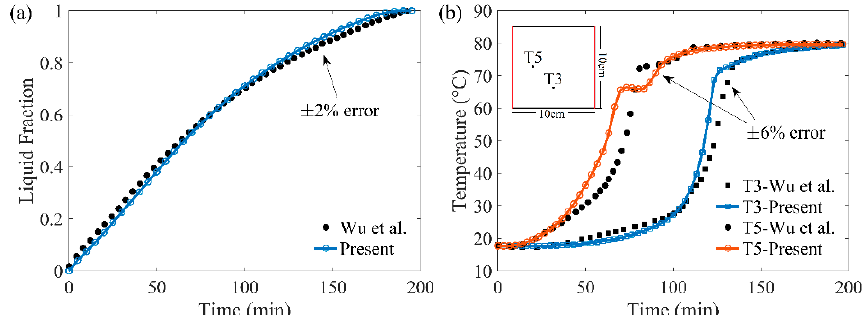
Figure 3. Validation of the present numerical model with the numerical and experimental data reported by Wu et al. [38]: ( a ) liquid fraction; ( b ) temperature profiles of T3 ( x = 5 cm, y = 2.5 cm) and T5 ( x = 2.5 cm, y = 5 cm).